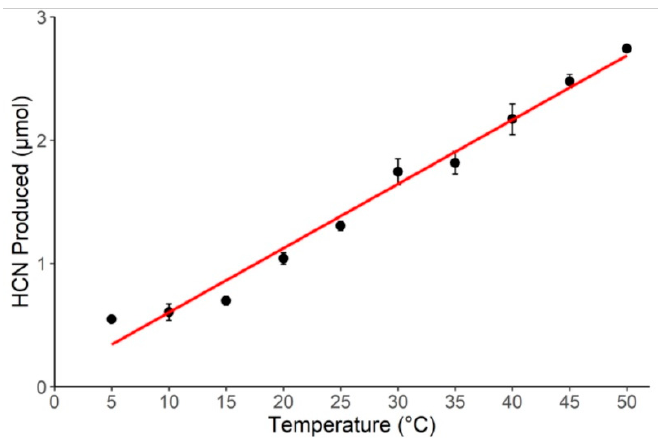
Figure 1. Effect of temperature on the production of HCN. Results are shown as the mean of 3 rep- licates at each temperature, with error bars representing ± 1 SE (R 2 = 0.96). Fitting exponential and 2nd-order polynomial curves to the data resulted in lower R 2 values.